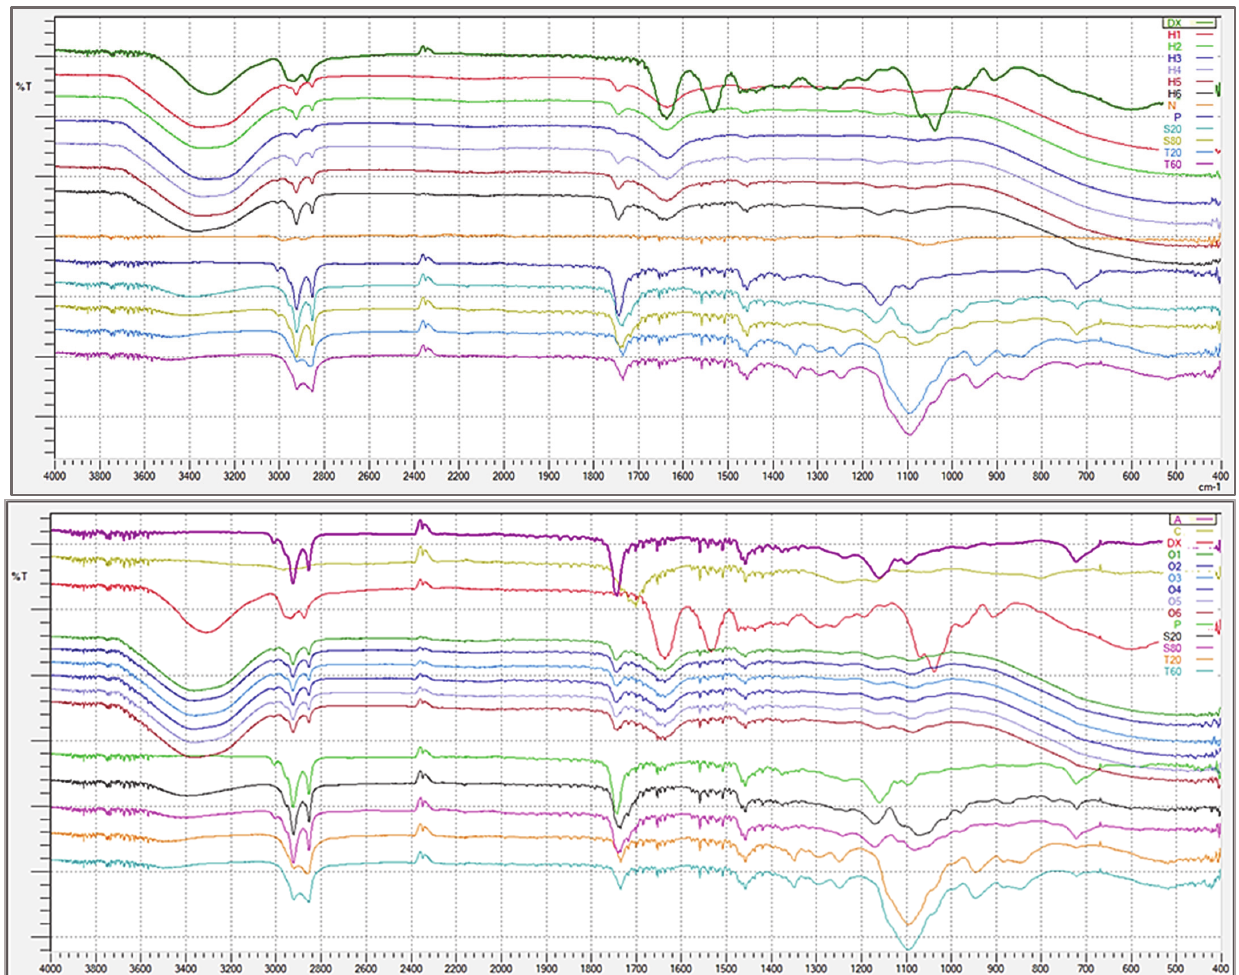
Figure 6. FT-IR spectra of hydrogels and organogels. Hydrogels are coded with letter H and organo- gels with the letter O. In addition, Dx: Dexpanthenol, N: NaCMC, P: Propolis, S20: Span 20, S80: Span 80, T20: Tween 80, T60: Tween 60, A: Sunflower oil, C: Carbopol 980.